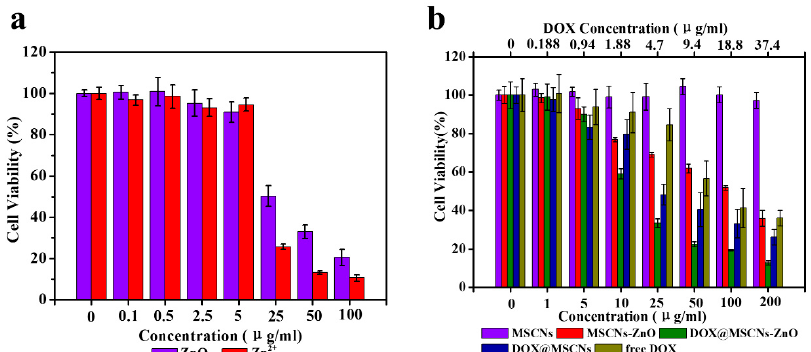
Figure12. In vitrocellviabilityof4T1cellstreatedwith( a )ZnOQDsandZn 2 + , ( b )MSCNs, Figure 12. In vitro cell viability of 4T1 cells treated with ( a ) ZnO QDs and Zn 2+ , ( b ) MSCNs, MSCNs- ZnO, DOX@MSCNs-ZnO, DOX@MSCNs and free DOX.